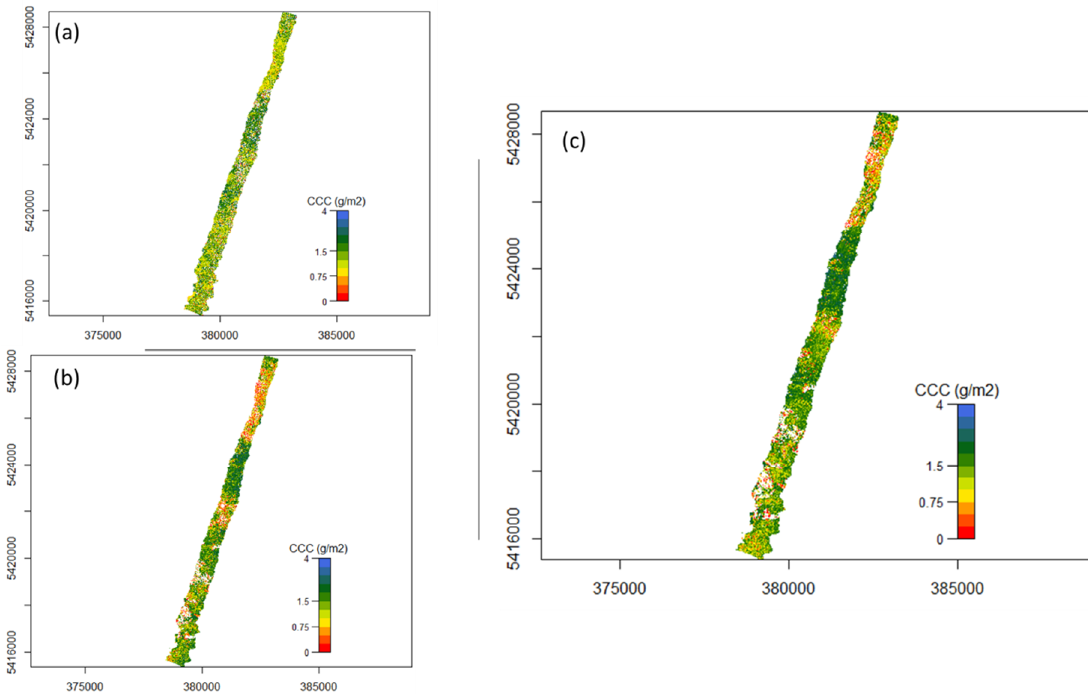
Figure A3. Flight line 149 mapped CCC ( a ) using nMTCI with wavelength 1 = 1819.52 nm, wavelength 2 = 1996.52 nm and wavelength 3 = 390.07 nm, ( b ) using nDD with wavelength 1 = 528.83 nm and wavelength 3 = 735.02 nm, and ( c ) using PLSR. .